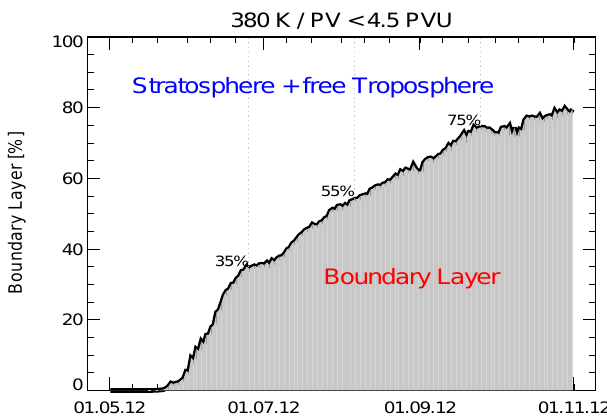
Figure 9. Temporal evolution of contributions of air masses from the boundary layer to the composition of the Asian monsoon anti- cyclone. The shown percentages are mean values calculated for air masses in Asia in the region between 15 and 50 ◦ N and 0 and 140 ◦ E at 380 ± 0 . 5K (see black rectangles in Fig. 7) with PV values lower than 4.5PVU marking the edge of the